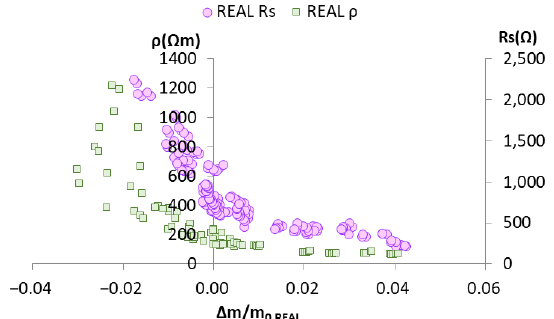
Figure 7. Graphical representation of the Rs values obtained with the sensors vs. real humidity variation in the corresponding samples (lilac circles) and a graph of the measured ρ values in the samples vs. real humidity variation in the corresponding samples (green squares).